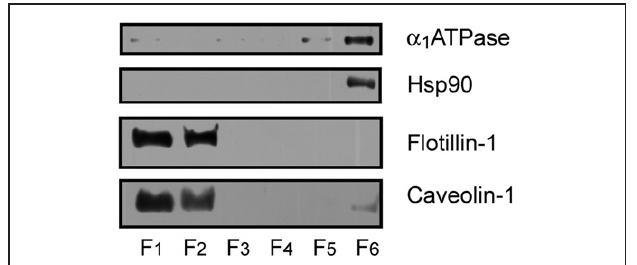
FIGURE 1 | Identification of protein markers in mouse cortex lipid raft by immunoblotting. The six raft and non-raft fractions obtained by sucrose gradients were loaded on 10% SDS-PAGE and processed for Western blotting, using specific antibodies directed to the different protein markers. Lipid raft resident proteins flotilllin-1 and caveolin-1 were abundantly detected in raft fractions 1 and 2, whereas the α 1 subunit of Na + /K + ATPase ( α 1ATPase), and the cytosolic protein Hsp90 were detected in non-raft fraction